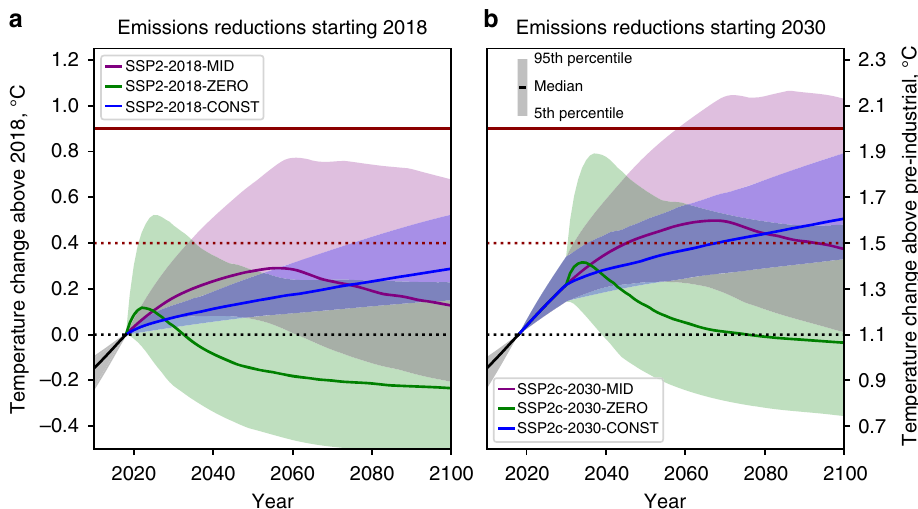
Fig. 1 Three different commitment types from 2018 and from 2030. a Constant 2018 forcing commitment (SSP2-2018-CONST; blue), committed temperature change owing to default retirement of current fossil infrastructure (SSP2-2018-MID; purple) and zero emissions commitment (SSP2-2018- ZERO; green) all assuming the SSP2 baseline emissions pathway until 2018. b As a , but with commitments beginning in 2030 (SSP2c-2030-CONST, SSP2c-2030-MID and SSP2c-2030-ZERO), and Nationally Determined Contributions implemented from 2020 (based on ref. 34 ). Shaded plumes show the 5 – 95 percentiles of the response under each scenario